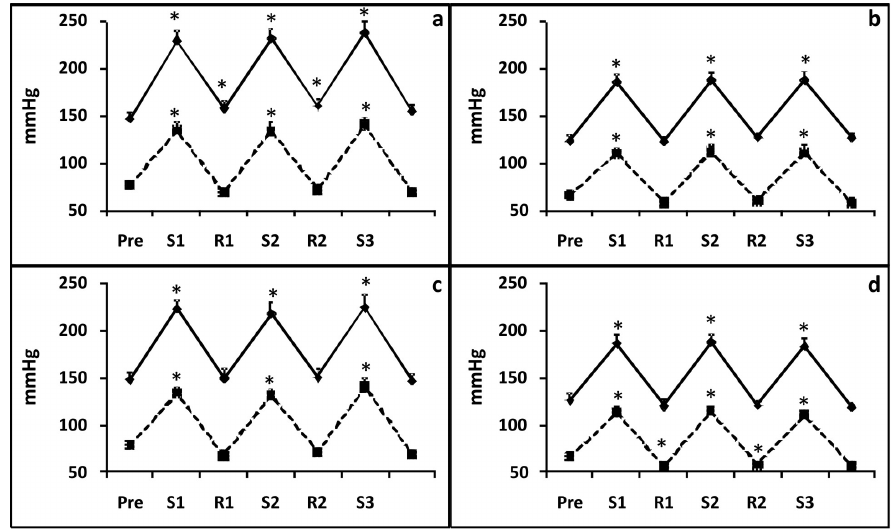
Figure 2 - Systolic blood pressure (SBP, solid lines) and diastolic blood pressure (DBP, dashed lines) measured before (Pre), during sets (S), and during rest periods (R) of knee extension exercises performed at 40% of the 1-repetition maximum (1RM, panels a and b) and 80% of 1RM (panels c and d) in hypertensive subjects (panels a and c) and normotensive subjects (panels b and d). *, P<0.05 vs. Pre.